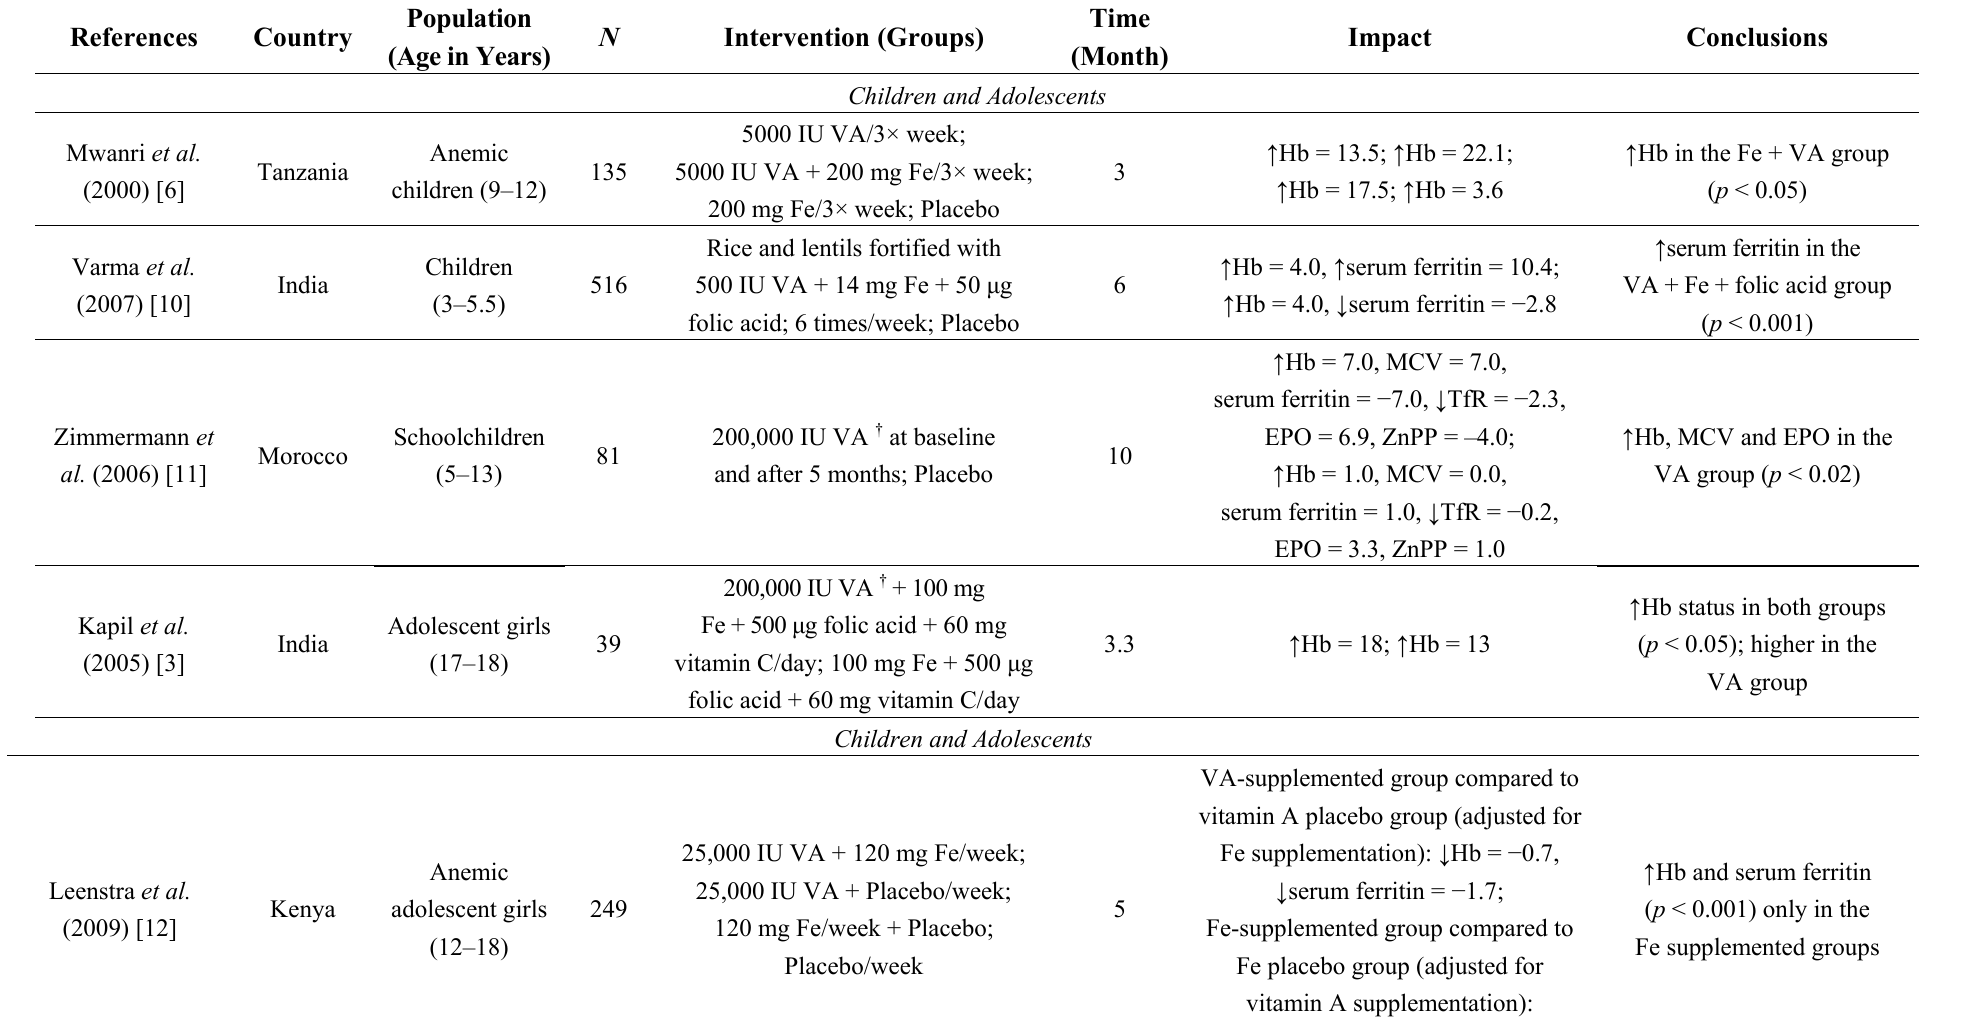
Table 1. Clinical trials that showed a significant impact of vitamin A supplementation/fortification alone or in combination with iron, folic acid, vitamin C and riboflavin on iron